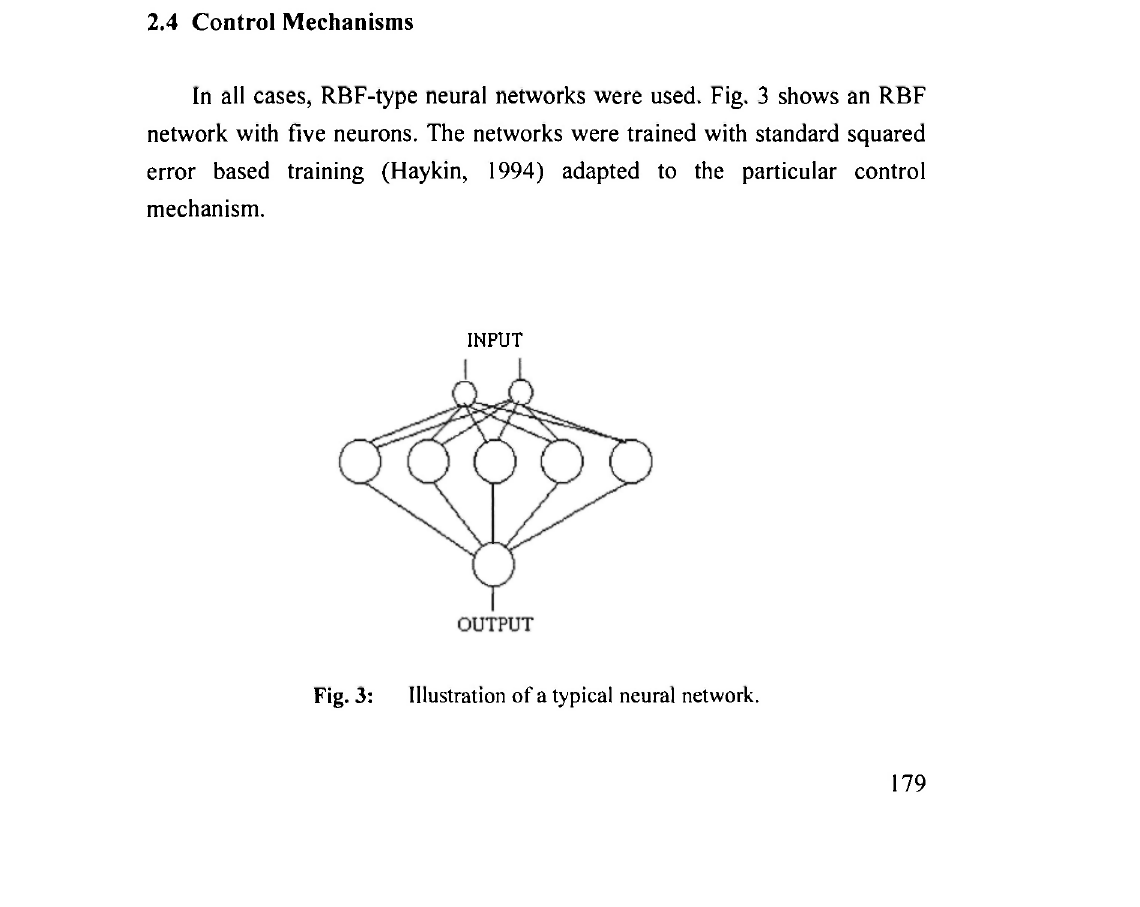
Fig. 3: Illustration of a typical neural